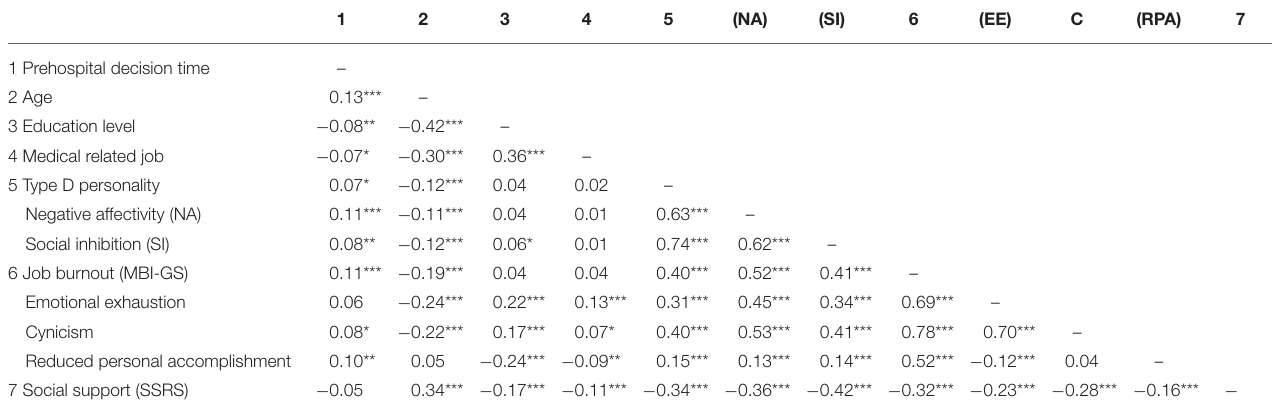
TABLE 2 | Spearman’s correlations between prehospital decision time and demographic, psychological features ( N = 1,032).